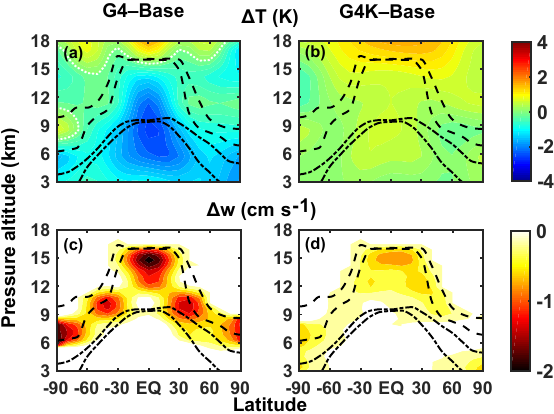
Figure 7. Zonally and time-averaged changes of temperature (a, b) and vertical velocity (c, d) in the G4 (a, c) and G4K (b, d) experi- ments with respect to the Base case (years 2030–2069). The dashed lines show the mean tropopause height (with seasonal variability). The dash-dotted lines show the mean height at which T = 238K (with seasonal variability). The dotted white lines in panel (a) high- light where (cid:49)T = 0K.